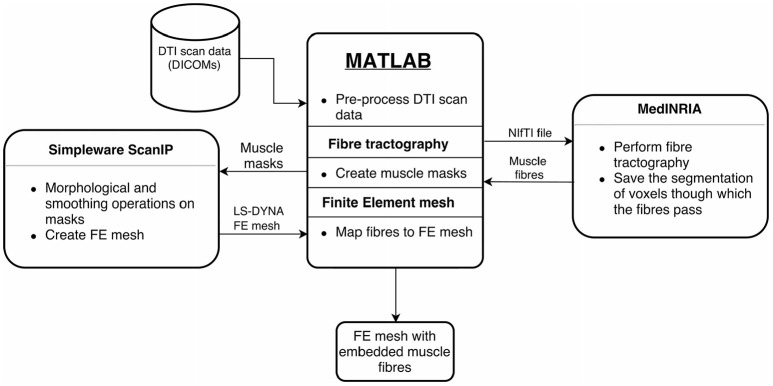
Overview of implemented workflow. The proposed workflow that converts the DT-MRI scans into patient-specific residual limb model is illustrated here. MATLAB handles data processing and transfer between the various software tools. Fibre tracking is done using MedINRIA. Binary muscle masks are created from the voxel segmentation data, which are loaded into Simpleware ScanIP. After image processing in ScanIP, the FE mesh is generated with the ScanIP +FE module. Finally, the extracted fibres are embedded into the FE mesh.